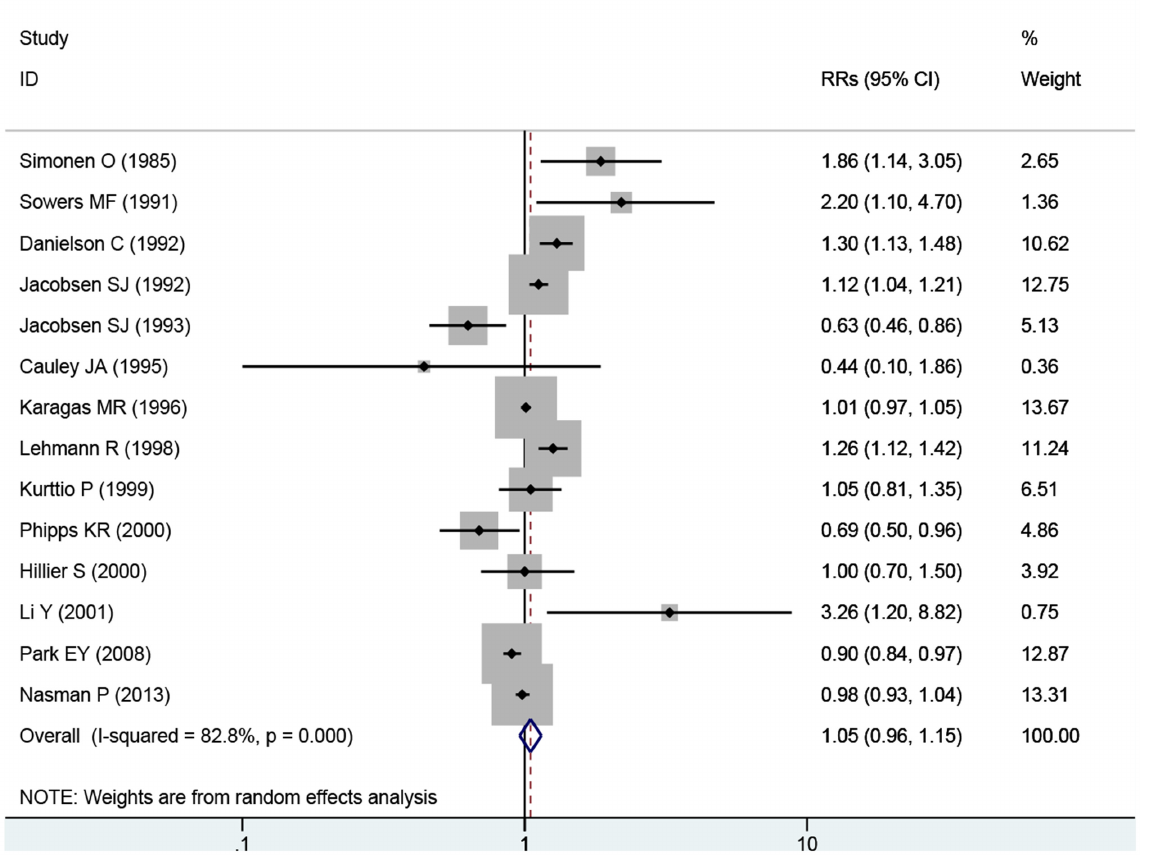
Fig 2. Forest plot of exposure to fluoride in the drinking water and hip fracture risk. Studies are pooled with a random-effects